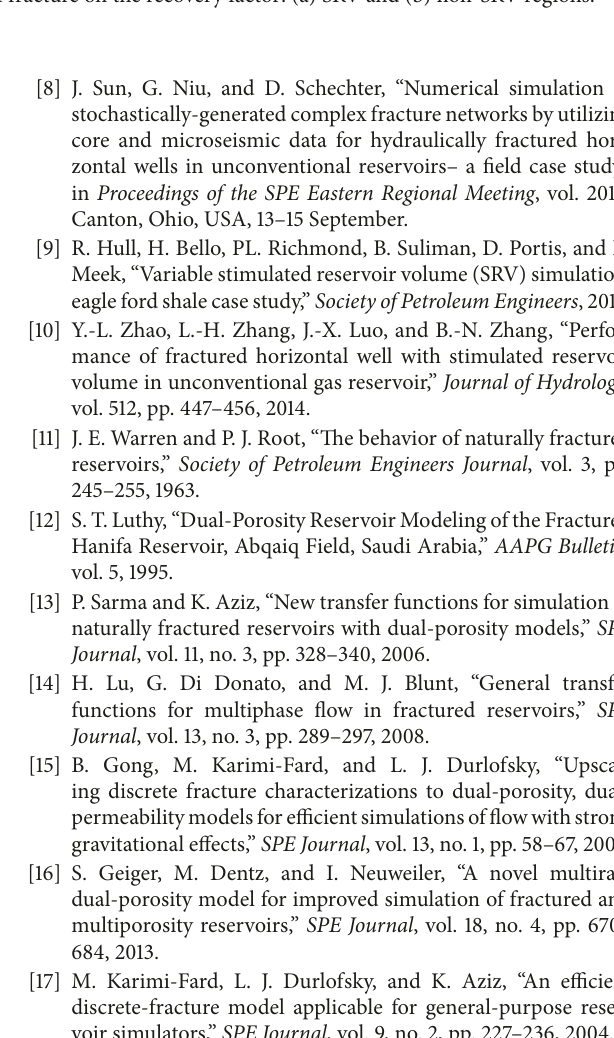
Figure 14: The effect of primary hydraulic fracture half-length of fracture on the recovery factor: (a) SRV and (b) non-SRV